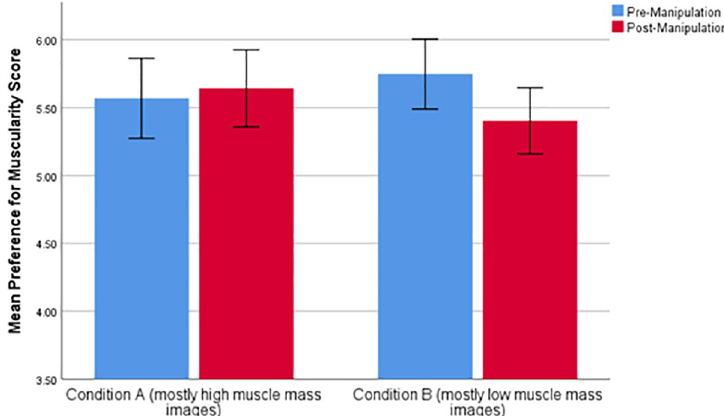
Fig 5. Mean changes in preference for muscularity following manipulation across each of the two conditions where 3.50 represents no preference to either image presented.